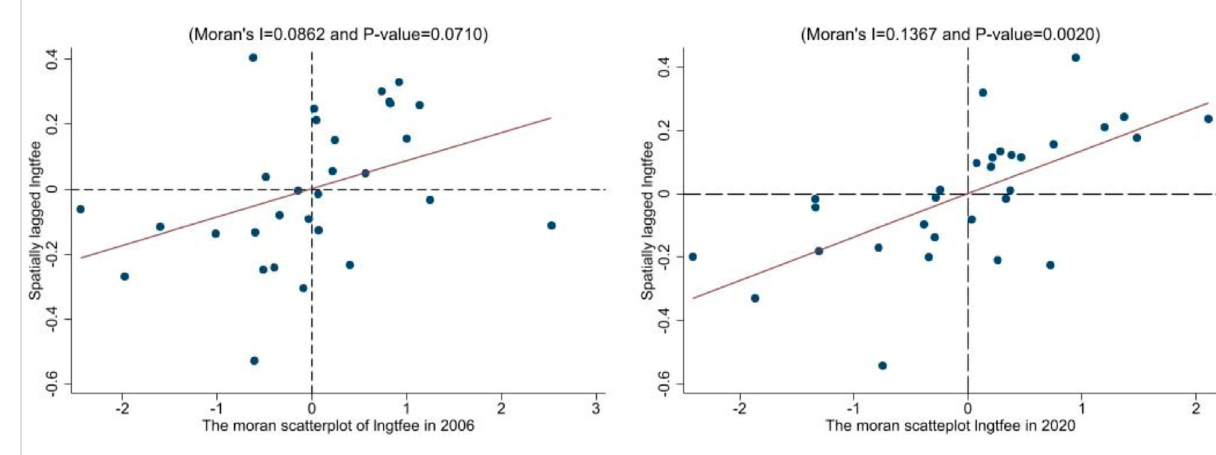
FIGURE 3 The local Moran scatter diagram of GTFEE in 2006 and 2020.